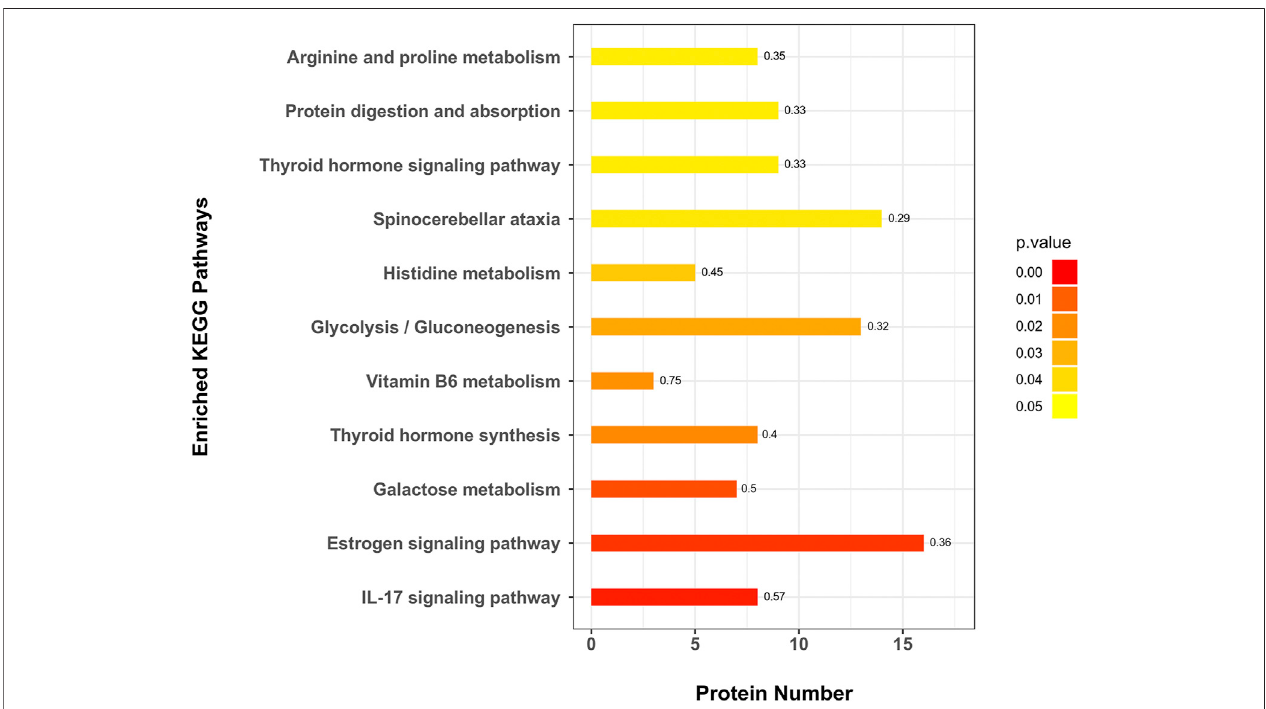
FIGURE 5 | KEGG pathway enrichment of DEPs in CPT and MC groups. The x -axis represents the amount of DEPs, the y -axis represents the pathway and the numbers represent the enrichment factor ratio of